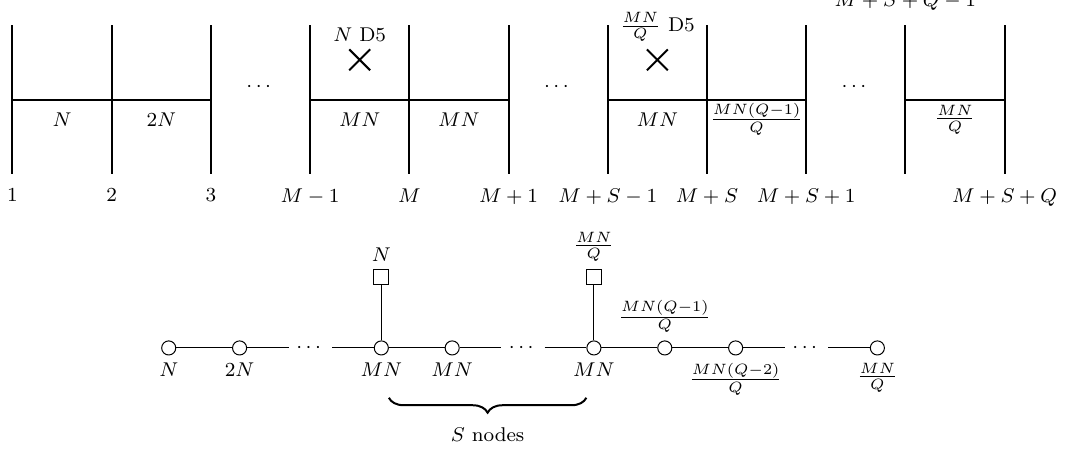
Figure 3 . The Hanany-Witten set-up and the associated quiver for the trapezoidal rank function. The conventions are those described